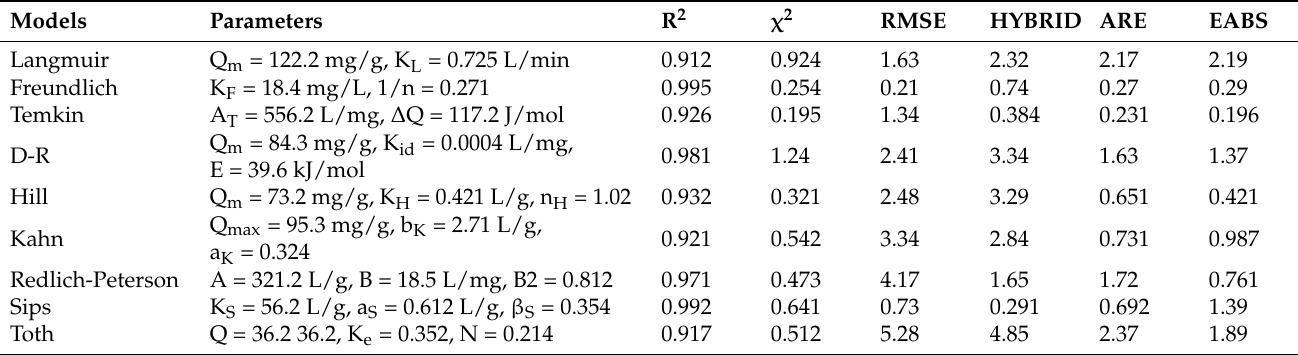
Figure 7. Nonlinear plot of isotherm models of FLX adsorption. Table 2. Results of the isotherm parameters of Levofloxacin adsorption onto MWCNTs/CoFe 2 O 4 nanocomposites.